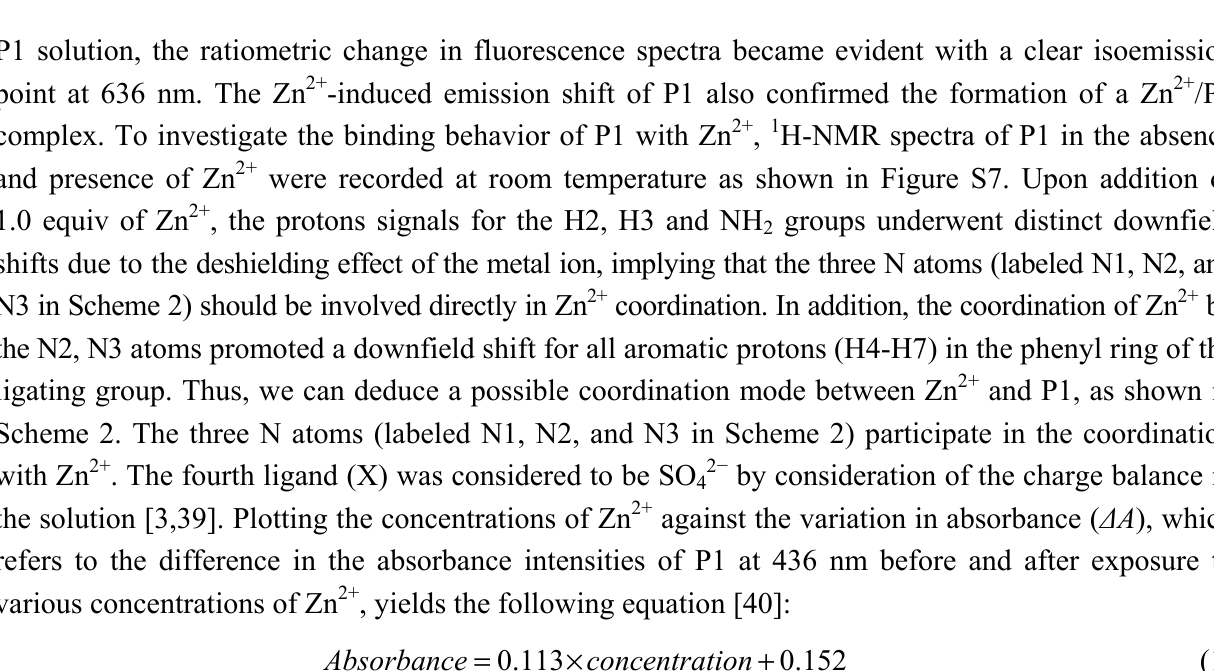
Figure 4. Fluorescence emission spectra of P1 (10 μ M) at pH 7.4 in the presence of different concentrations of Zn 2+ (0, 0.5, 1.0, 5.0, 10, 50, and 100 μ M) in EtOH/H (1:1, v/v) solution or recovered with addition of